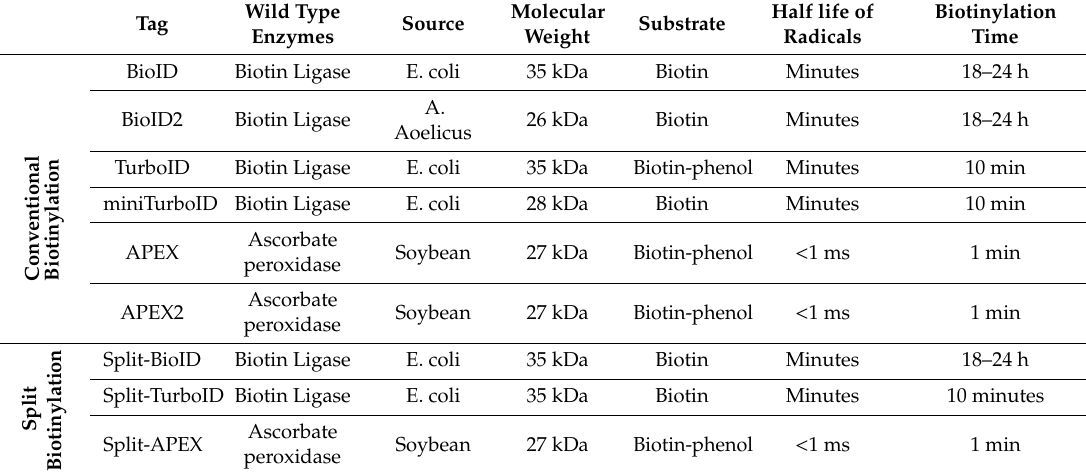
Table 1. Evolution of proximity-based labeling enzymes. The table shows the comparison of biotin ligase and peroxidase-based labeling enzymes with respect to their di ff erent